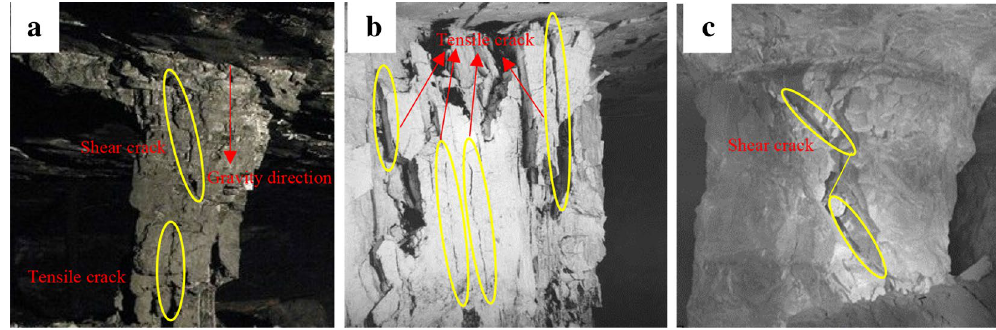
Figure 1. Engineering cases about pillars failure 1 . ( a ) Inclination limestone pillar; ( b ) Vertical gypsum pillar; ( c ) Low inclination stone